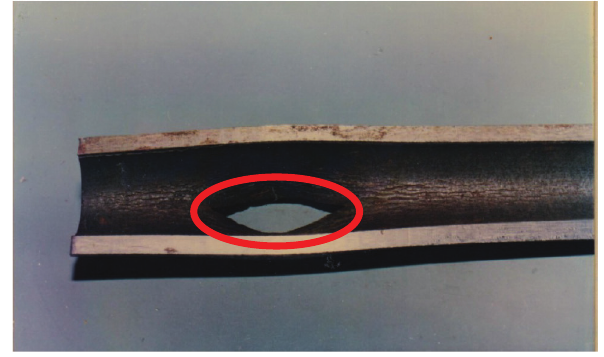
Fig. 3: Inner surface of the failed tube